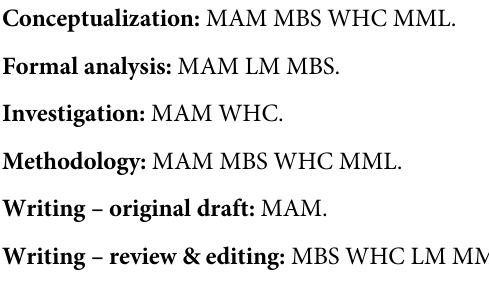
duction (ETEC antigen stimulated minus media), D3 –pre-vaccination, by total CD4+ T cells in Resistant (green squares) and Susceptible (red circles) volunteers. (cid:3) p < 0.05 S4 Fig. Activation of and cytokine production by total CD4+ T cells. A-C) Net CD154 expression (A) , IFN- γ (B) , and IL-17A (C) production (CFA/I stimulated minus media), circles) volunteers. S5 Fig. Activation of and cytokine production by pT . A) Net CD154 expression B-D) Net fh production of IFN- γ (B ), IL-17A (C) , IL-21 (D) , and net ICOS expression (E) (CFA/I stimu- lated minus media), D3 –pre-vaccination, by pT in Resistant (green squares) and Susceptible fh (red circles) volunteers. S6 Fig. Association of integrin α 4 β 7 expression by pT and IgA B . Linear regression anal- fh M ysis comparing percentages of pT expressing integrin α 4 β 7 ( α 4 β 7+ CCR4-) following stimu- fh lation with whole cell homogenate on day 3 post-challenge versus the LPS-specific IgA B as a M percent of total IgA B on (A) day 14 and (B) day 28 M